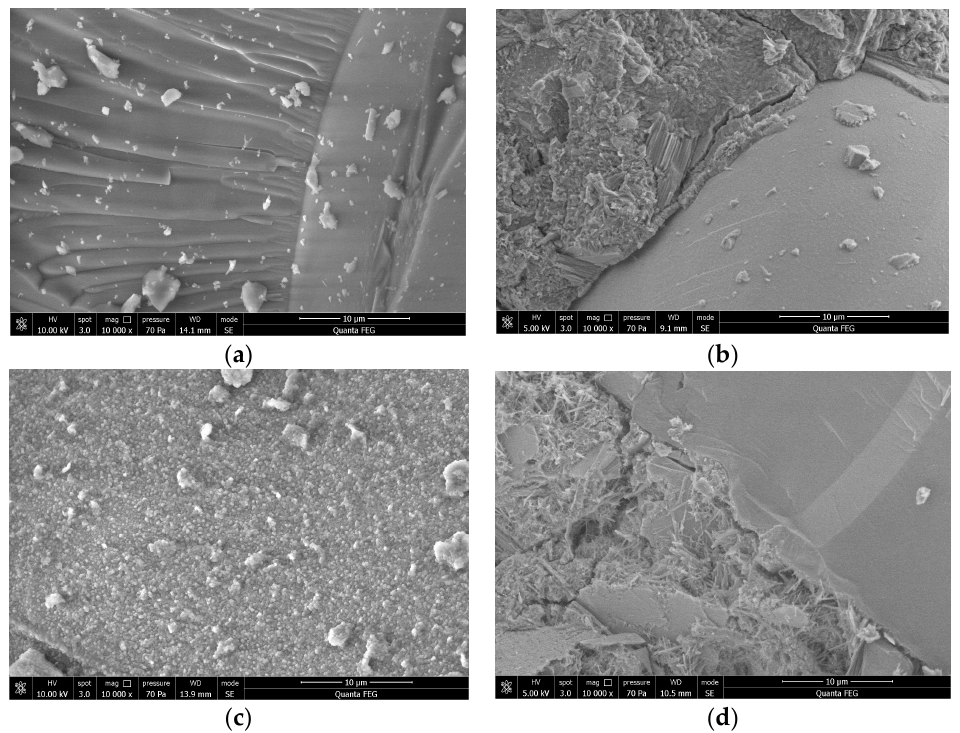
Figure 10. SEM micrographs of ( a ) 75 μ m WGP, ( b ) mortar-75G10, ( c ) pretreated 75 μ m WGP by 2% alkali and 2% Na (cid:2870) SO (cid:2872) , and ( d ) mortar-75G10S2H2.